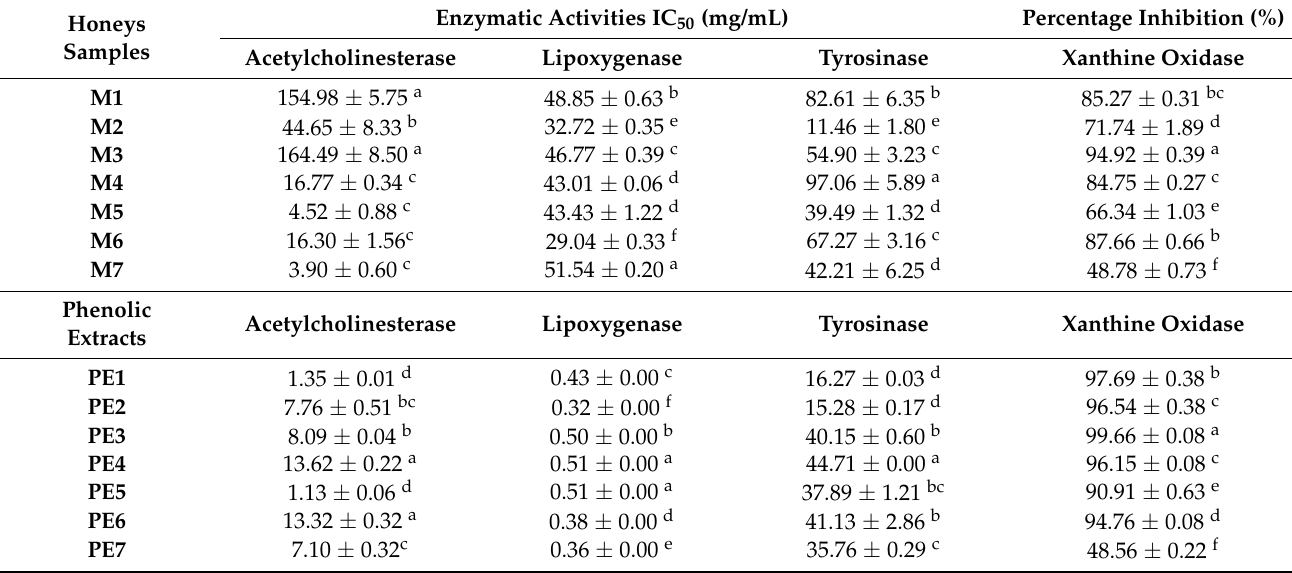
Table 8. Data presenting the different enzymatic activities (Acetylcholinesterase, lipoxygenase, tyrosinase and xanthine oxidase inhibition) of Euphorbia honey samples (M1, M2, M3, M4, M5, M6, M7) and their own phenolic extract (PE1, PE2, PE3, PE4, PE5, PE6, PE7). The results of M2 and M3 samples were previously published [13]. Reproduced with permission from Oumaima Boutoub et al., Antioxidant activity and enzyme inhibitory potential of Euphorbia resinifera and E. officinarum honeys from Morocco and plant aqueous extracts; published by Springer Na-ture, 2020.